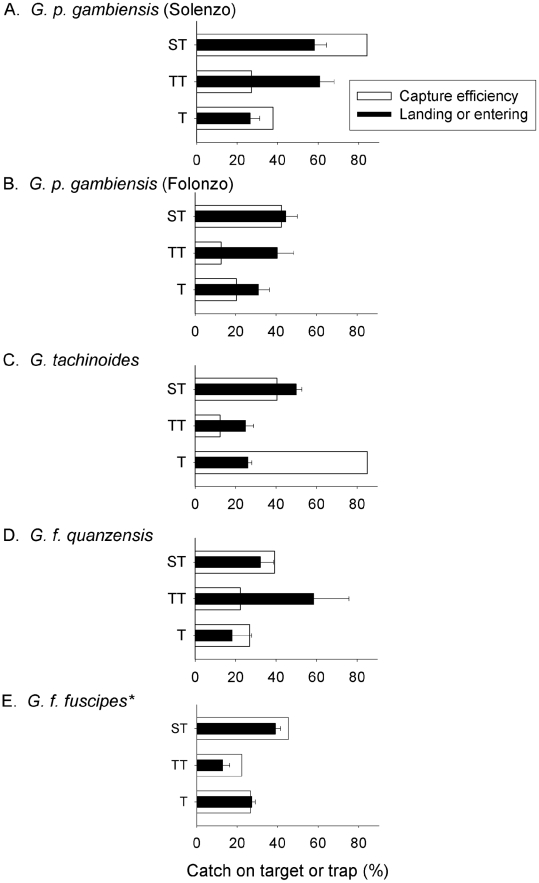
Landing or entering response for tsetse on a standard target 1m2 (ST), a small 25×25cm target (TT) or biconical trap (T).For devices with a flanking net, landing or entering responses were estimated by expressing number caught landing on the target or entering the trap as a percentage of the total (device+flanking net) catch. For unaccompanied traps and targets, capture efficiency was estimated by expressing the mean catch of the trap or target as a proportion of the mean catch from a trap+flanking net. A  =  G. p. gambiensis at Solenzo; B  =  G. p. gambiensis at Folonzo; C  =  G. tachinoides; D  =  G. f. quanzensis; E  =  G. f. fuscipes. *Data for G. f. fuscipes derived from Lindh et al., 2009.